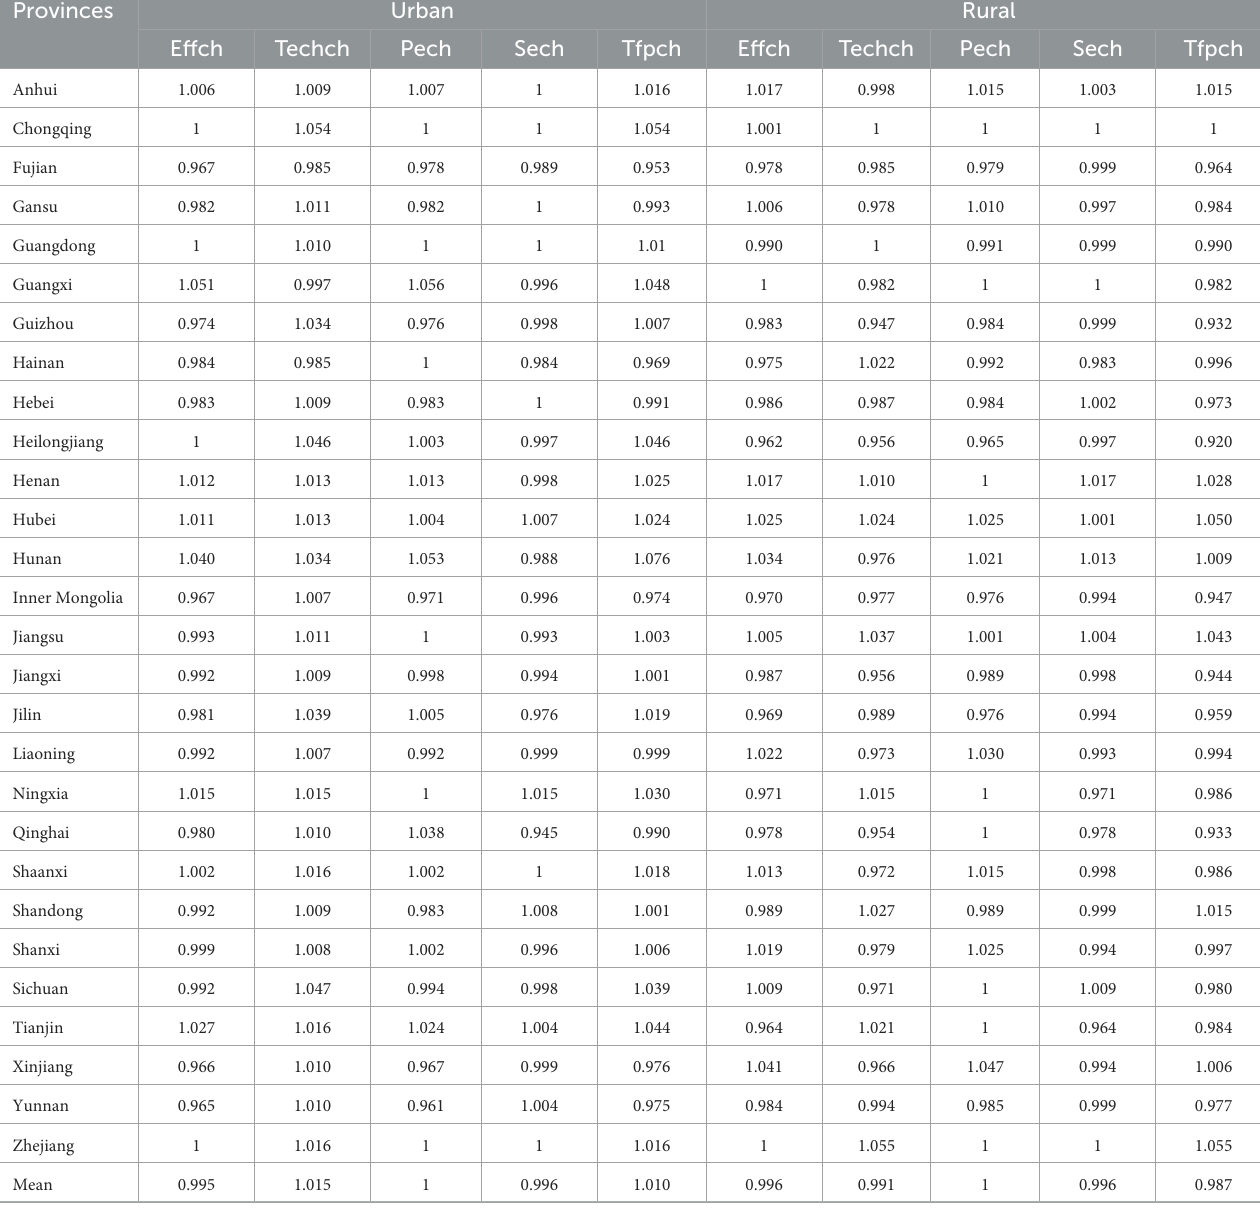
TABLE 5 The Malmquist index and its decomposition for PHCIs at the provincial level, 2009-2019. Provinces